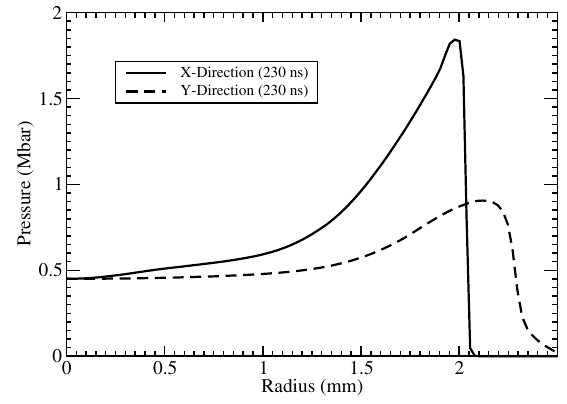
FIG. 20. Specific energy deposition vs radius ( x and y direc- tions) at t (cid:3) 20 ns , using an elliptic focal spot, (cid:13) (cid:3) 0 : 6 mm . The rest of the beam parameters and the and (cid:13) y target parameters are the same as in the case of Fig. 5.